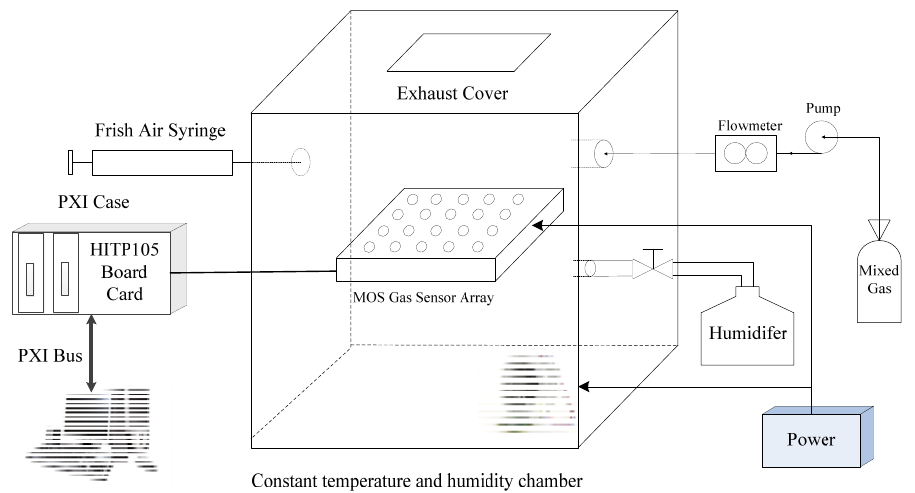
Figure 3. Binary mixed gas detection experimental system.